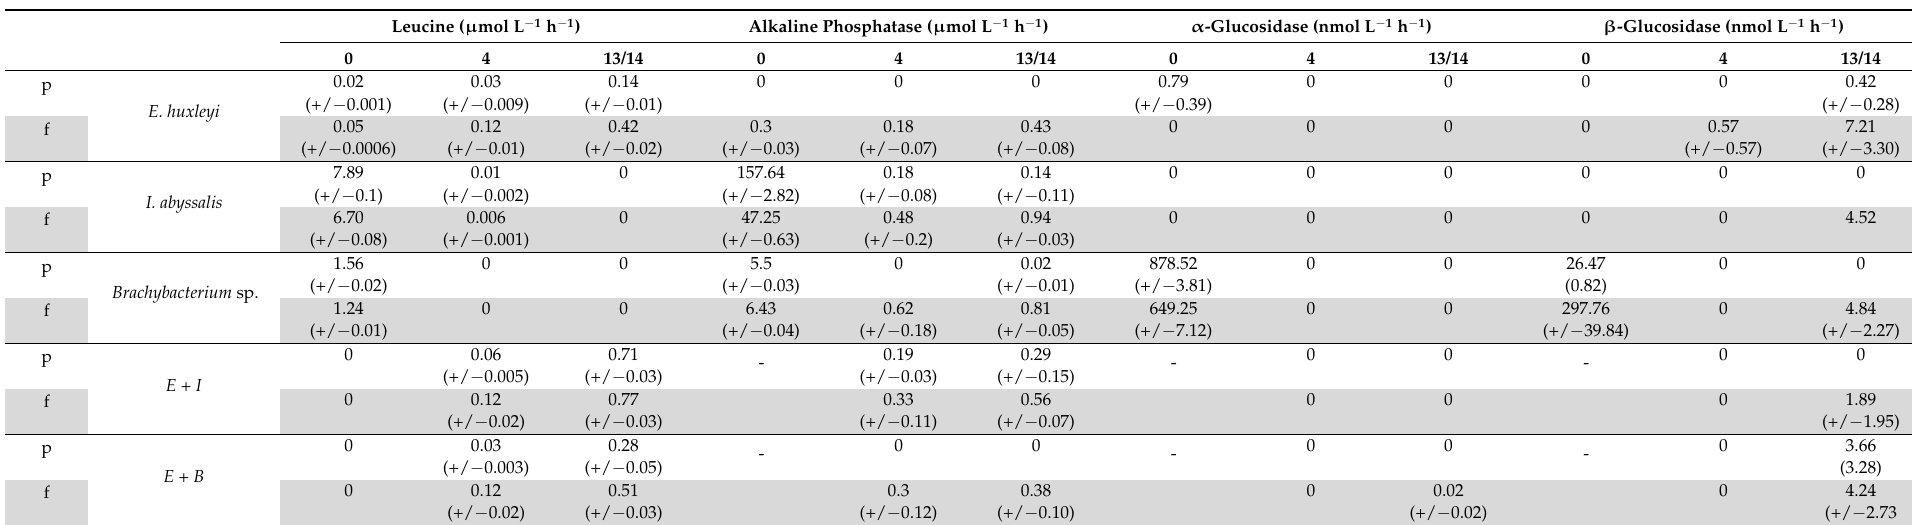
Table 2. Enzymatic activities at the start (0) and after 4 and 13/14 days of incubation, under present and future CO 2